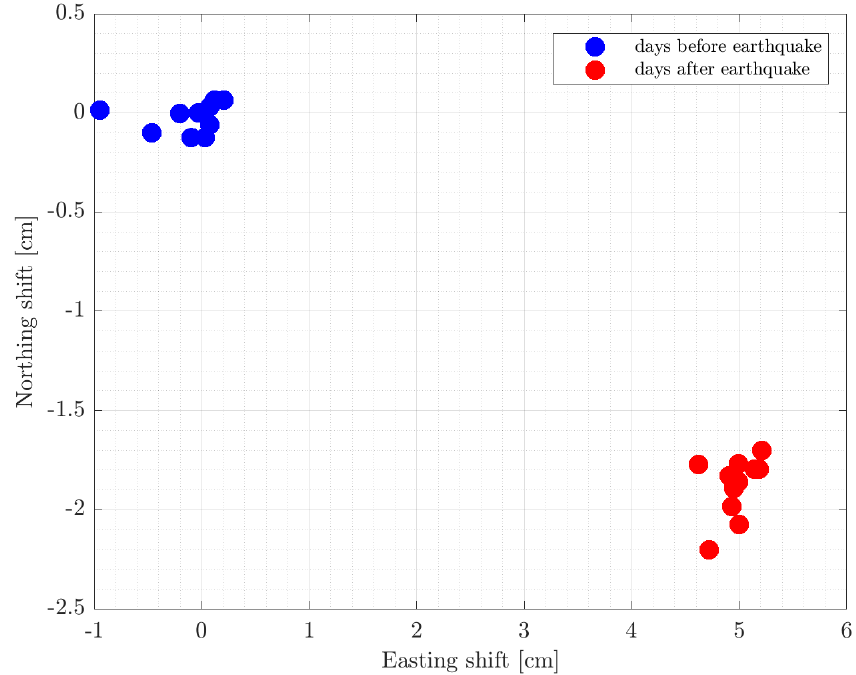
Figure 10. The graph shows two-dimensional displacement of a CROPOS’s SISA station due to the earthquake, with ten blue dots representing SISA’s location ten days before the earthquake and ten red dots the position during ten days after the earthquake.